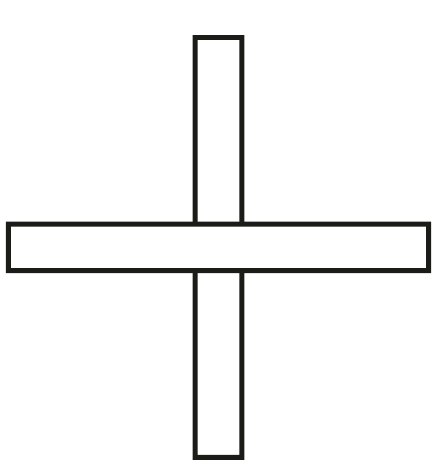
Figure 2: Typical plain cruciform